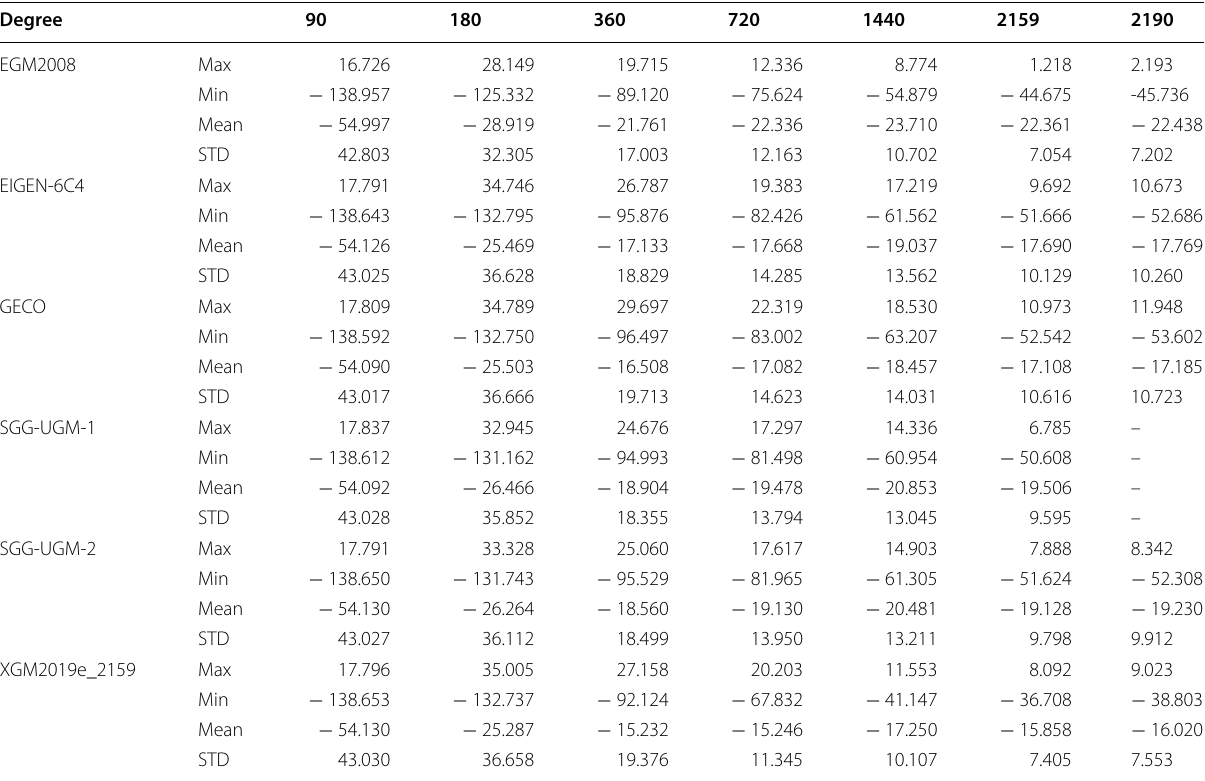
Table 3 The statistics of the differences between the gravity anomaly derived from gravity field models and the measured data in Sichuan Basin (unit: mGal) Degree 90